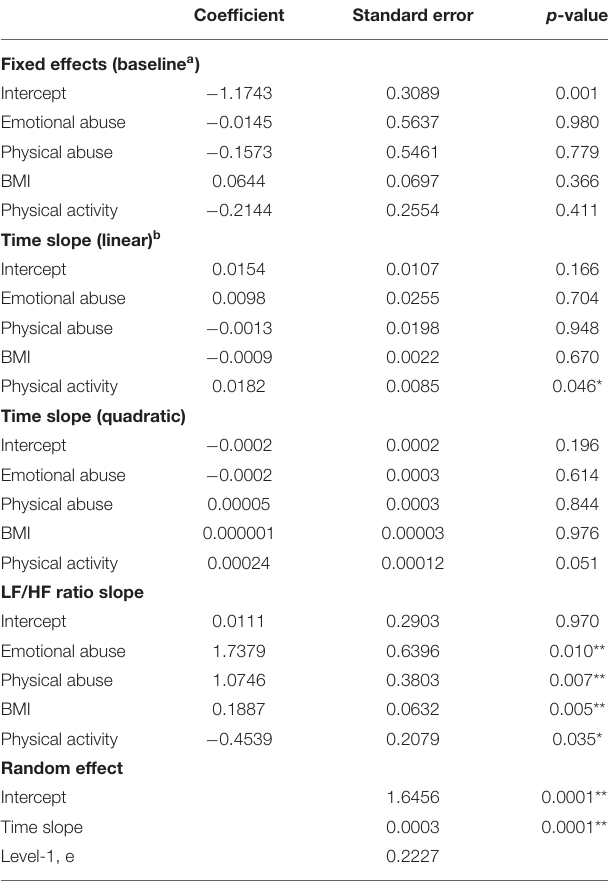
TABLE 3 | Final hierarchical linear model estimates for salivary IL-6 ( N =